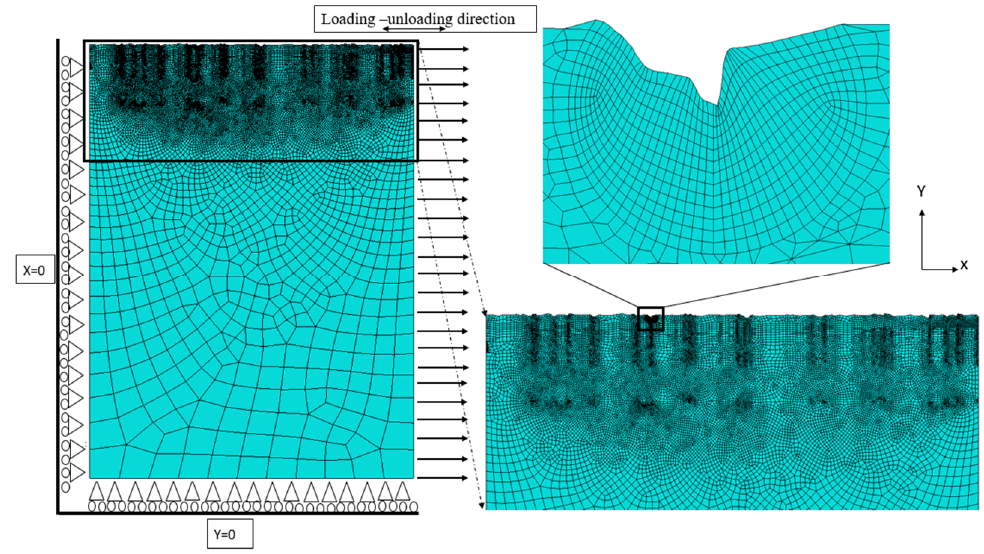
Figure 3. Two-dimensional real surface topography model and local mesh [27].